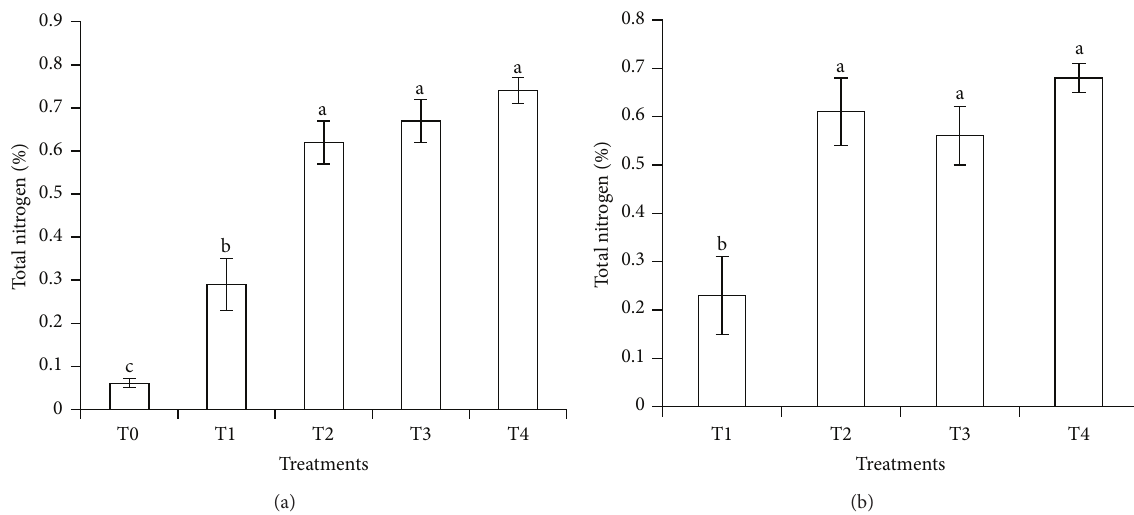
Figure 9: (a) Total nitrogen retained in soil at 30 days of leaching and (b) total nitrogen retained in soil after 30 days of leaching (after subtracting the contribution of T0). Note . T0: 64g soil (no urea); T1: 64 g soil + 7.40 g urea (no additives); T2: 64g soil + 7.40g urea + 6 g clinoptilolite zeolite; T3: 64 g soil + 7.40 g urea + 1.54g compost; T4: 64 g soil + 7.40 g urea + 1.54g compost + 6 g clinoptilolite zeolite. Means with different letters indicate significant difference between treatments by Tukey’s test at 𝑃 ≤ 0.05 . Note . Bar represents standard error of the mean.